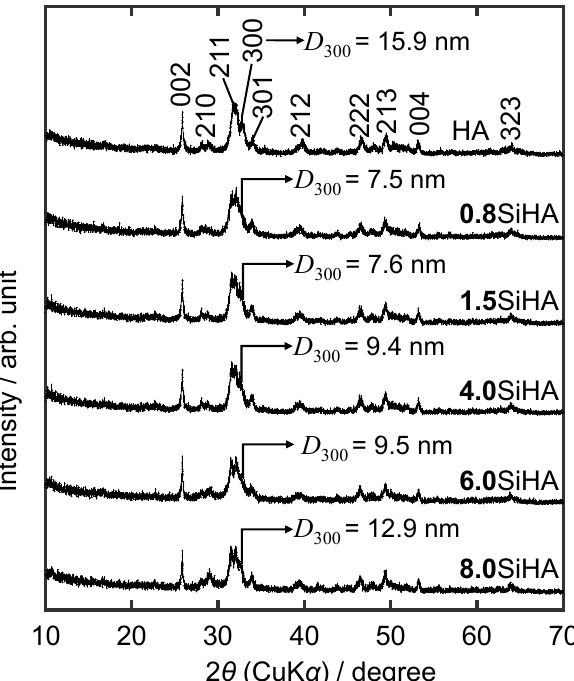
Figure 2. XRD patterns of the HA and SiHA particles (Inset: D 300 values). Figure 3a shows the deconvolution curves and fitting results of the spectra of the SiHA particles provided by their Q 0 ~ Q 2 components. At the lower Si concentration ( 0.8 SiHA and 1.5 SiHA), only Q 0 peak was observed. However, at the higher Si concentration ( 4.0 SiHA, 6.0 SiHA and 8.0 SiHA), the Q 1 and Q 2 peaks appeared. The Q 0 peak of the SiO 4 tetrahedron